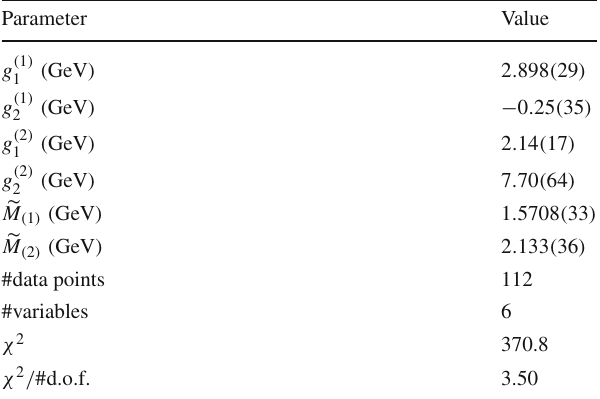
Table 1 Parameters of the combined fit of argument and absolute value of ˆ T ,definedinEq.(18),tothecorrespondingdataofRef.[63]asshown in Fig. 2